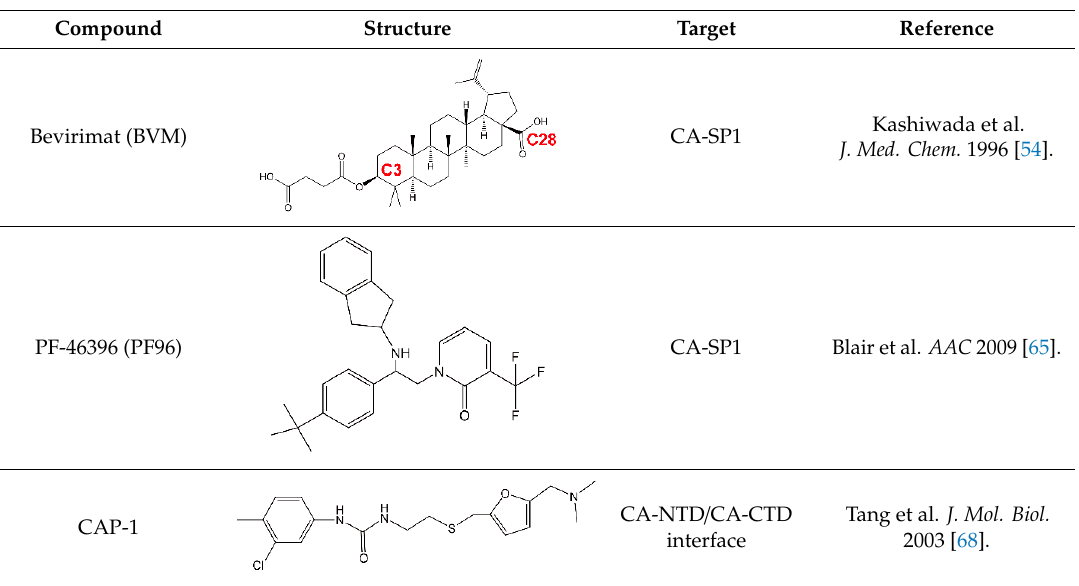
Table 1. Maturation inhibitors discussed in this review.